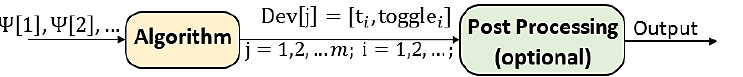
Figure 4. High-Level Process Overview. Post-processing is essential for measures and performance evaluation.